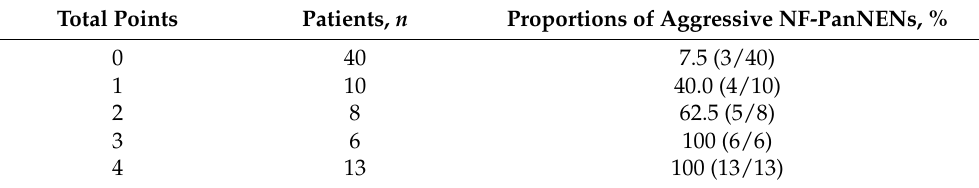
Table 5. The proportions of aggressive NF-PanNENs according to the total points.